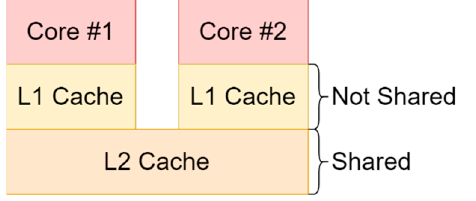
Figure 13. L1 & L2 cache